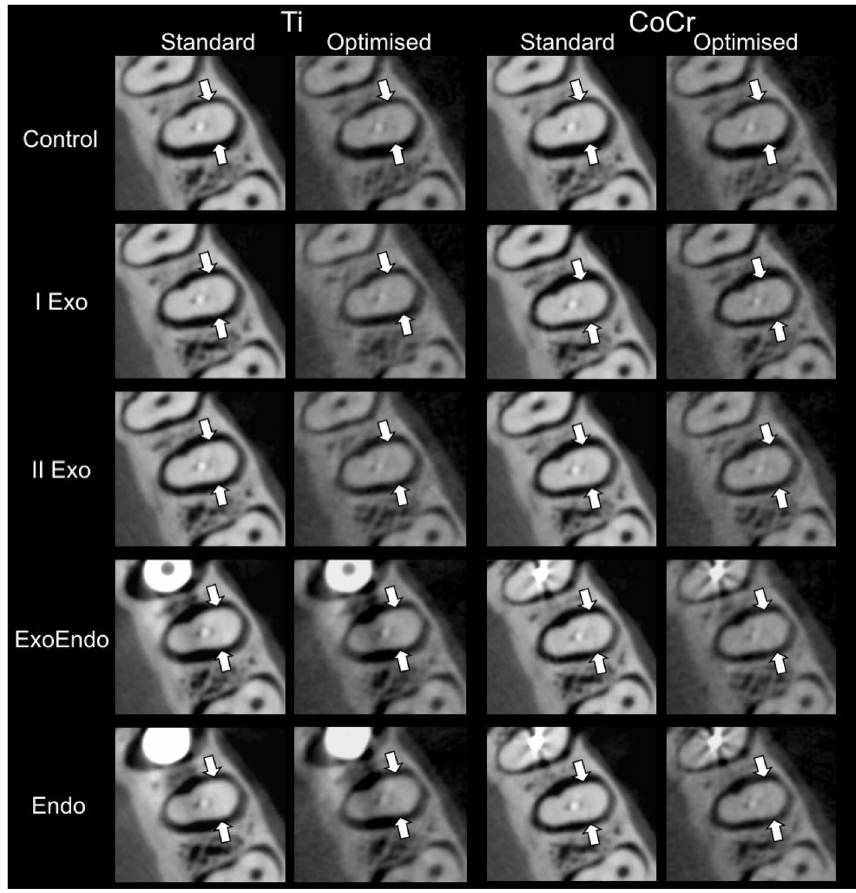
Figure 3. Cropped axial reconstructions of the standard and optimised CBCT protocols in different dispositions of titanium implants and cobalt-chromium intracanal posts in the mandible. The white arrows highlight the vertical root fracture in the second premolar.